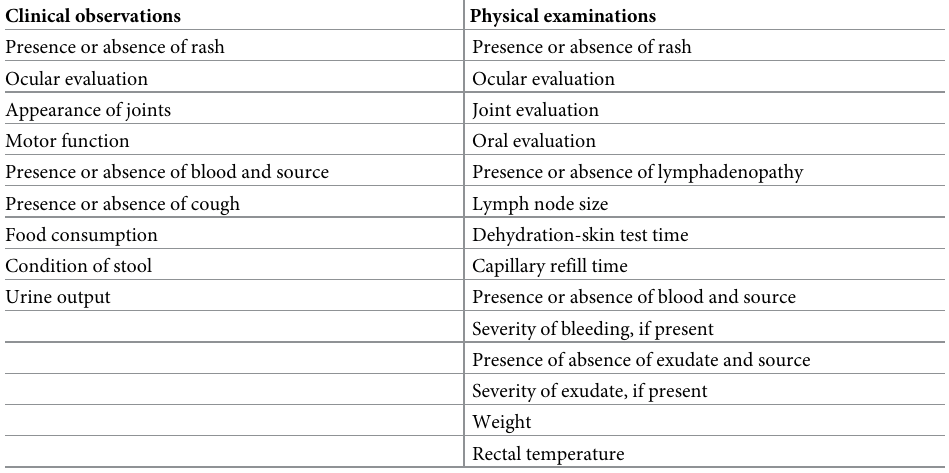
Table 2. Clinical observations and physical